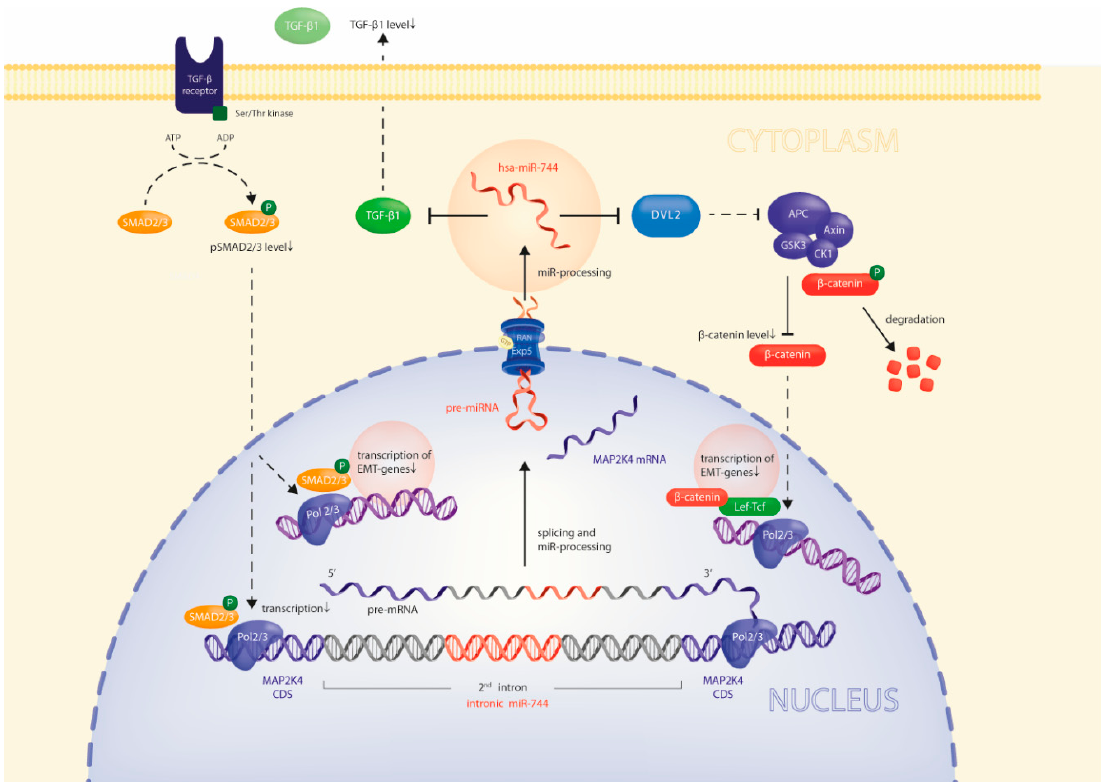
Figure 6. Model of miR-744 effects on it’s host gene´s expression and on tumor cell migration. Direct repression of DVL2 and TGFB1 by miR-744 inhibits SMAD- and beta-Catenin-dependent transcriptional activity, respectively, thus reducing expression of EMT- and pro-invasive genes. Moreover, miR-744 constitutes a second-order negative feedback loop on its host gene MAP2K4 through direct repression of TGFB1 levels, concomitantly repressing host gene and miR-744 expression.